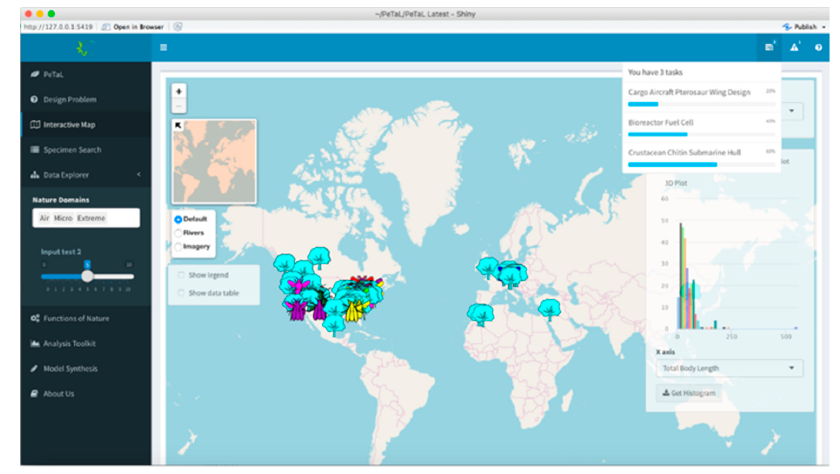
Figure 23. Screenshot of the PeTaL R user interface showing geographic scatter of filtered data.